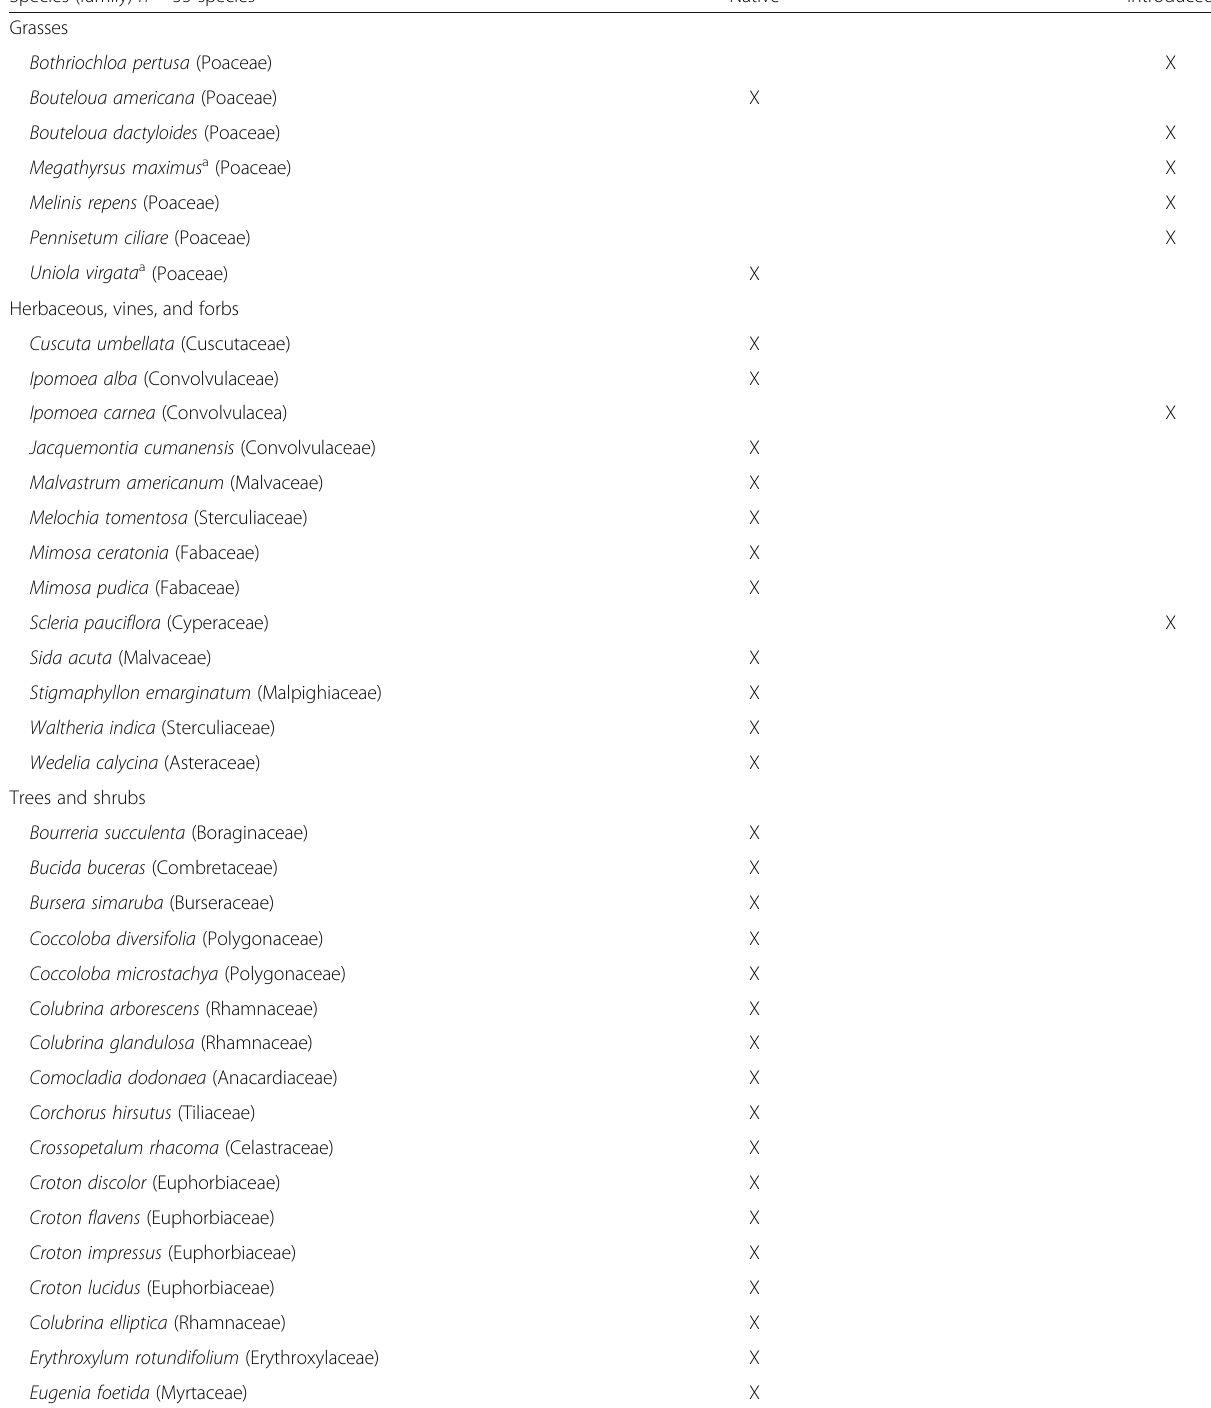
Table 2 Plant species and species origin grouped by growth habit recorded in vegetation surveys of the 38 transverse transects along the 570-m-long bulldozer trail from July 2012 to July 2013 in the Ensenada sector of Guánica Forest, Puerto Rico Species (family) n = 55